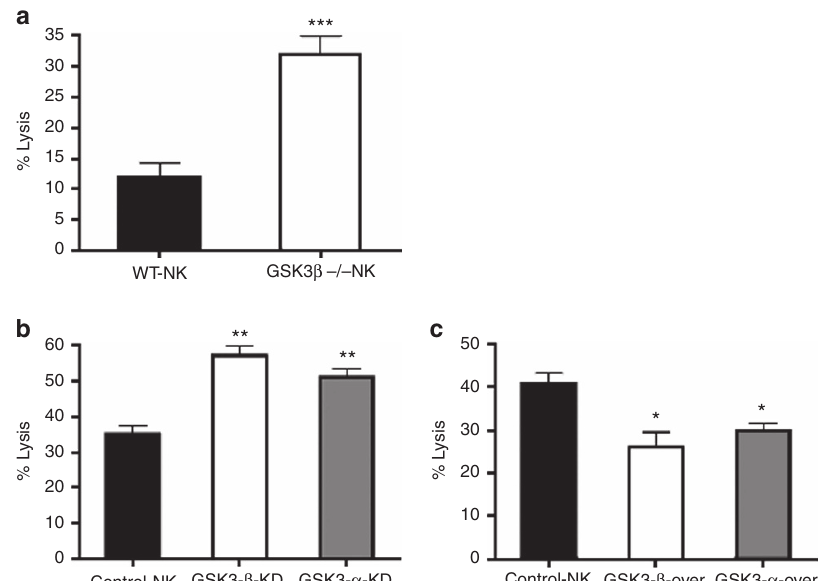
Figure 3 | Genetic evidence of the role of GSK3 in NK cell activity against AML cells. ( a ) NK cells were isolated from three GSK3 b deficient mice or three wild-type controls were incubated with WEHI-231 mouse cancer cells and target cell lysis was measured using the calcein-AM assay. Experiment is performed four times. ( b , c ) NK cells lentivirally transduced with empty vector, GSK3 b shRNA (GSK3- b -KD), GSK3 a shRNA (GSK3- a -KD), GSK3 b (GSK3- b -over) or GSK3 a (GSK3- a -over) were incubated with OCI-AML3 cells and target cell lysis was measured using the calcein-AM assay. (unpaired Student’s